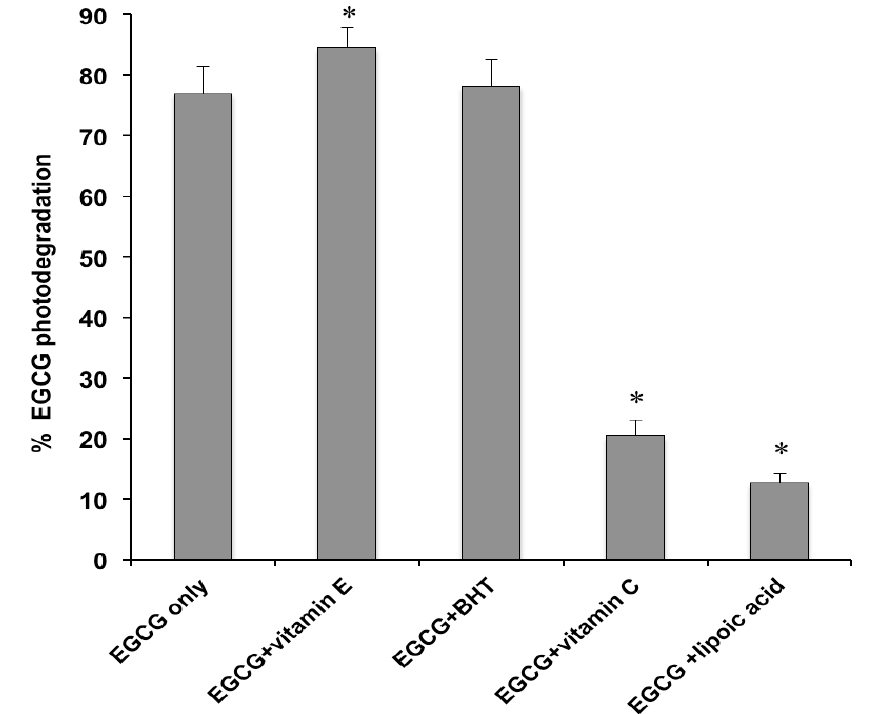
Figure 1. EGCG photodegradation (%) in its formulations, without or with co-antioxidants (EGCG/co-antioxidant molar ratio, 1), after 1 h irradiation with the solar simulator. Each value is the mean ± S.D. of at least six experiments. * p < 0.05 (ANOVA) vs . EGCG only.